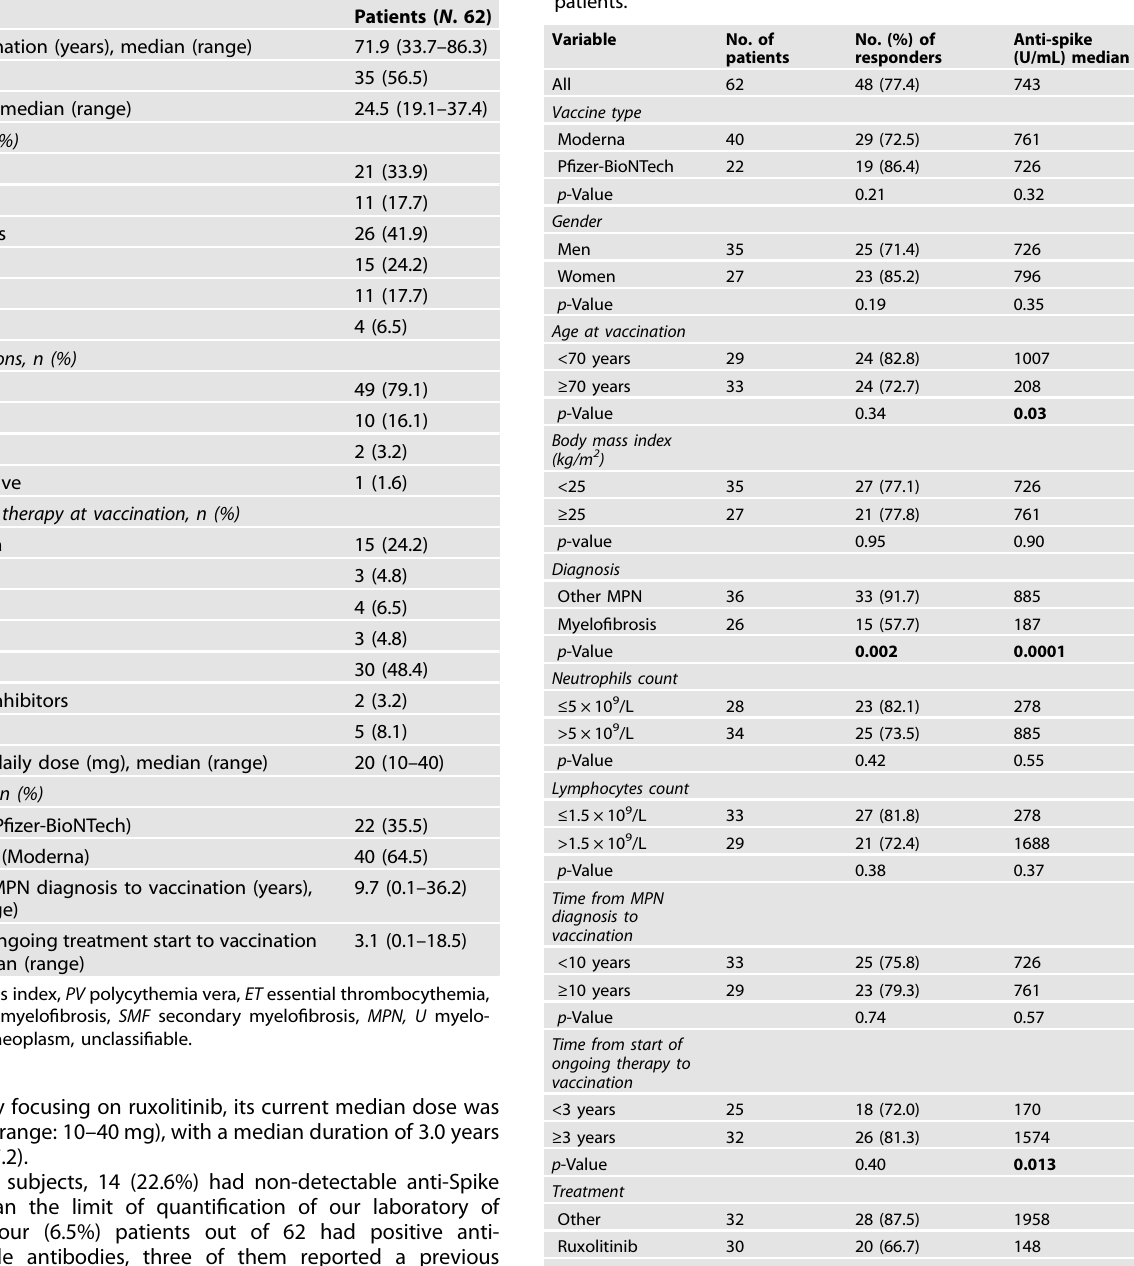
Table 1. Patients ’ characteristics.